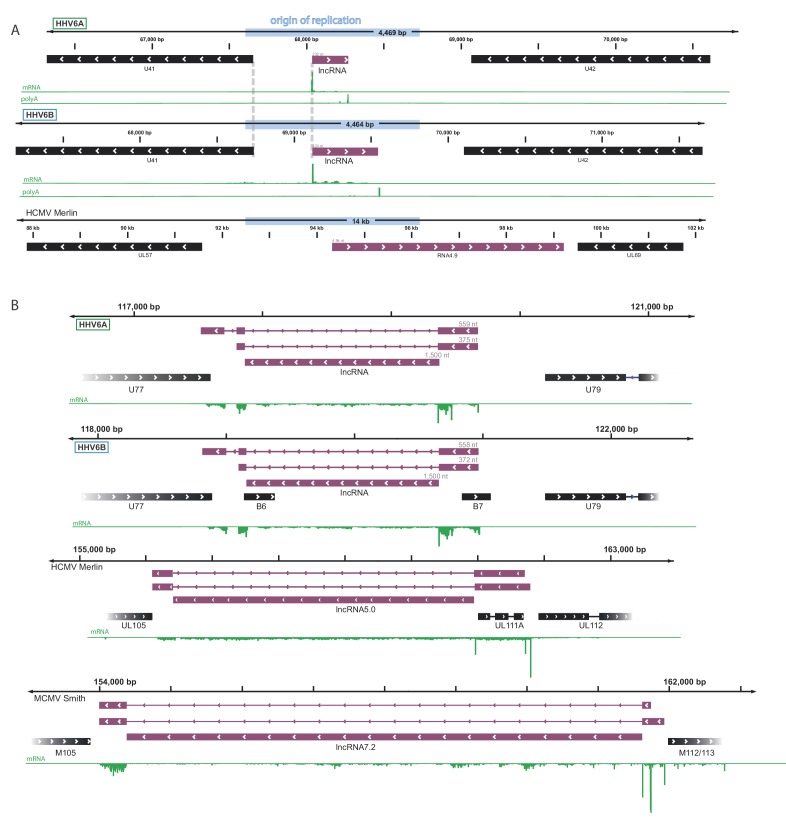
Conservation by synteny of newly discovered HHV-6 lncRNAs.(A and B) Reads from RNA-seq are presented in green. Black rectangles mark canonical ORFs and purple rectangles mark the putative lncRNAs (A) a lncRNA initiating within the lytic origin of replication of HHV-6A, HHV-6B and HCMV (RNA4.9). (B) A spliced lncRNA, likely generating a stable intron, transcribed from the locus between the viral helicase gene and a conserved early phosphoprotein gene in HHV-6A, HHV-6B, HCMV and Murine CMV (MCMV).